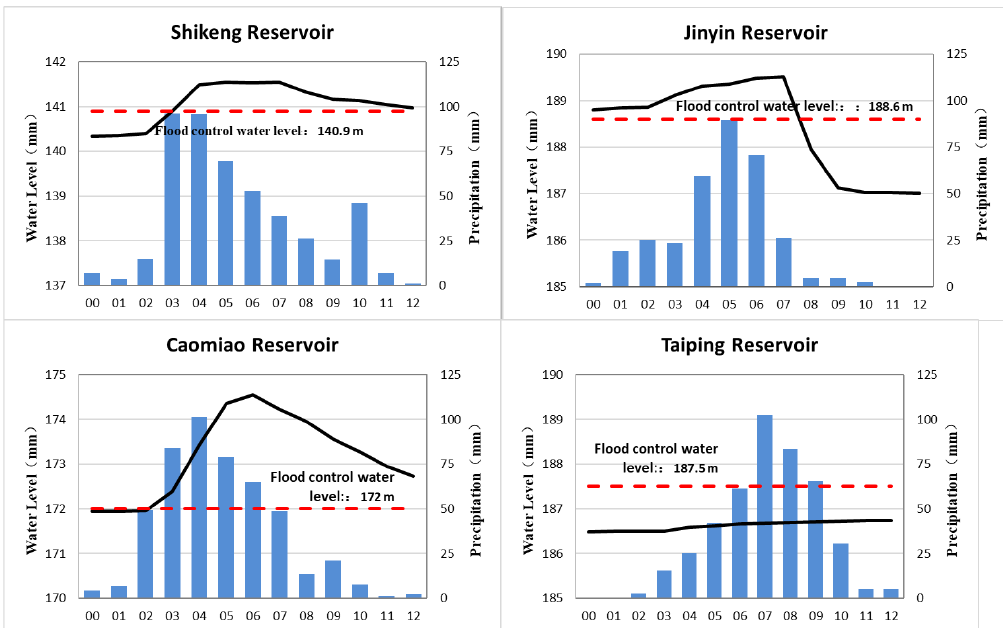
Figure 3. Changes of rainfall and water level in Shijinyin, Caomiao, Taiping, and Shikeng reservoirs.